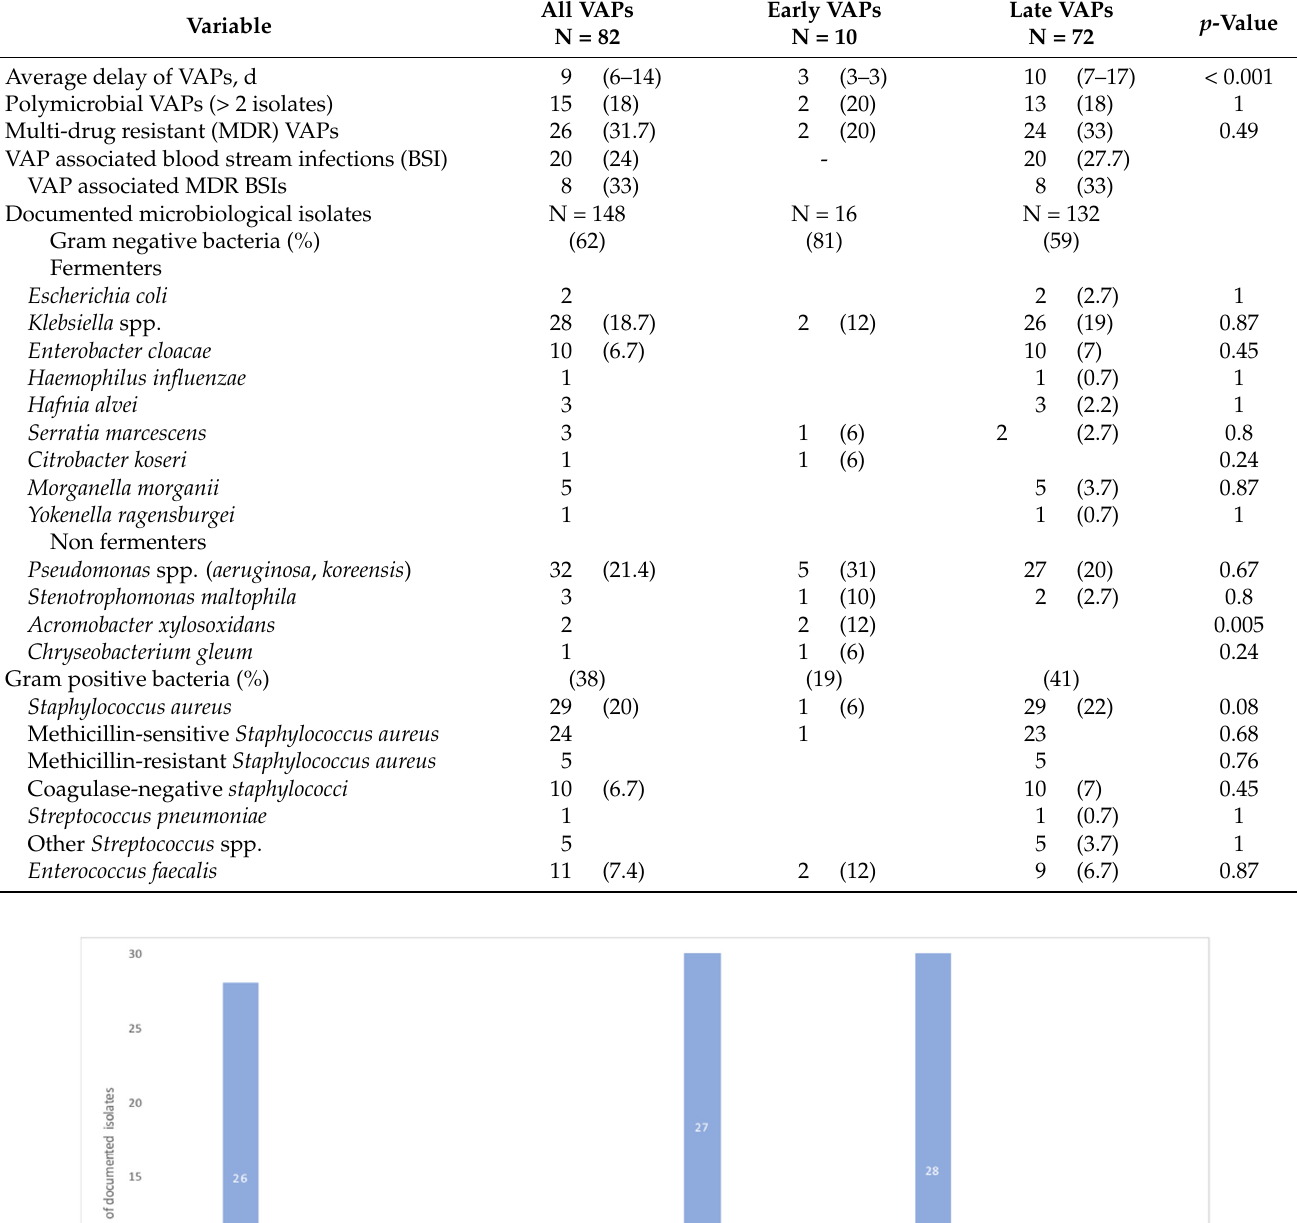
Table 4. Ventilation-acquired pneumonia characteristics and bacterial documentation.